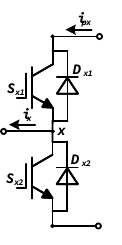
Figure 2. The topology of a single leg.